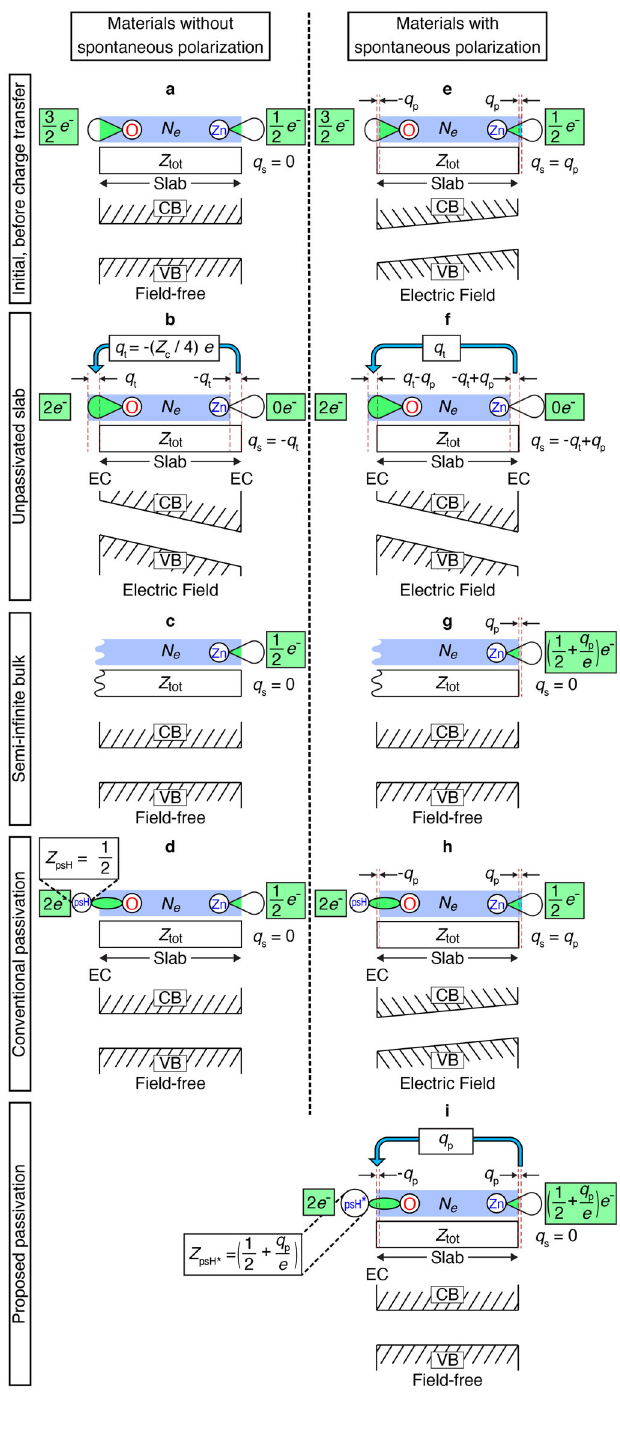
with Z c /4 (i.e., 1/2) electron, as shown in Fig. 3a. Because cation dbs have higher orbital energy compared to anion dbs, in a fi nite- size slab a charge transfer from the Zn to the O side of the slab occurs, denoted as q t in Fig. 3b. This results in two oppositely charged surfaces that form a sheet capacitor. As a consequence of the charged capacitor, a macroscopic electric fi eld arises, as shown in the band structure in the lower part of Fig. 3b. The schematic picture is con fi rmed by an actual DFT calculation (cf. Supplemen- tary Fig. 1). After charge transfer both ZB ZnO surfaces ful fi ll EC 32 ,